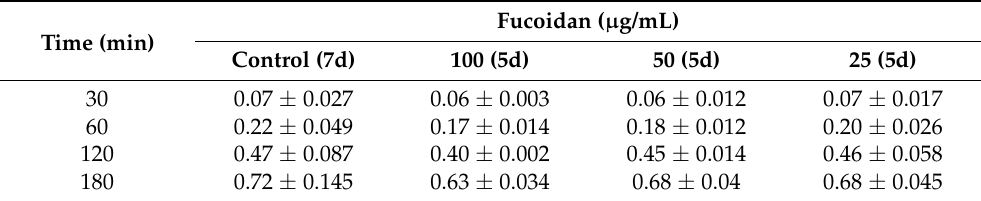
Table 2. The transmittance (RT) of fluorescein sodium (%) at a different time and con-centration of Fucoidan.